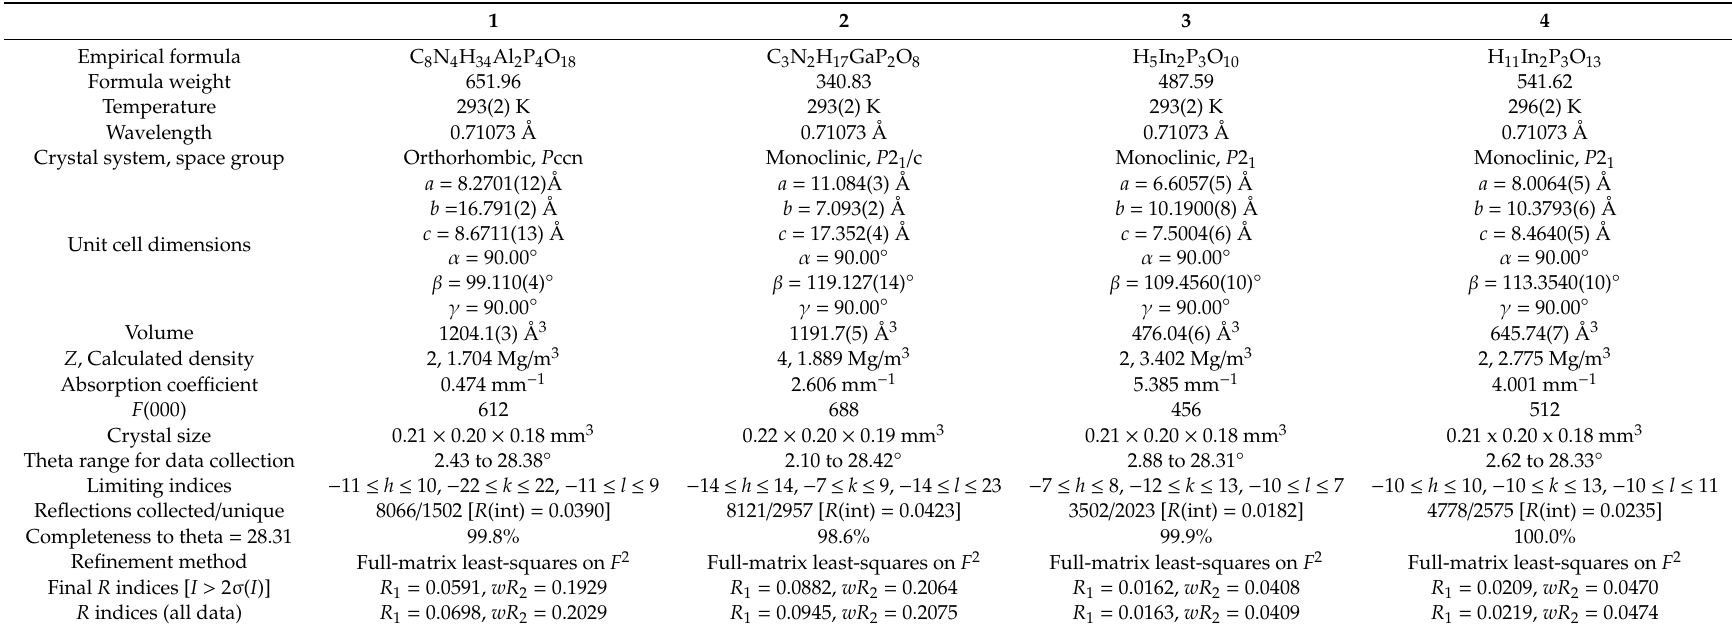
Table 1. Crystal data and structure refinement for compounds